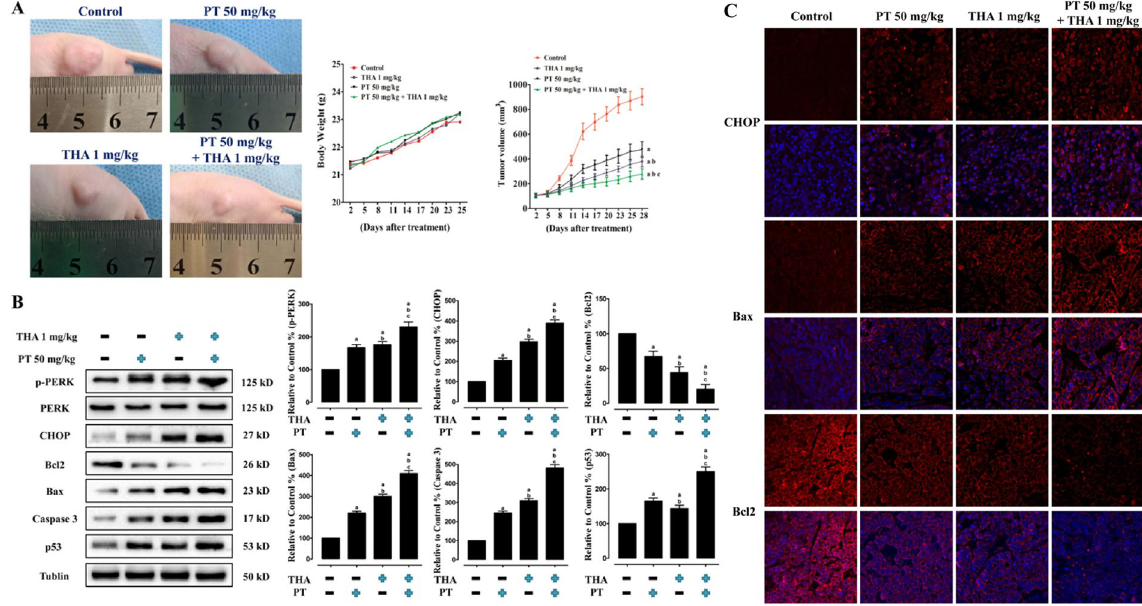
Figure 8. Effect of PT treatment combined with THA on tumor volume, body weight of nude mice, ERS pathways and apoptosis-associated proteins on PC9 tumor xenografts in vivo . ( A ) Photographs showing tumor xenograft morphologies in each group, changes in body weight of nude mice, and tumor growth curve drawn from the tumor volumes and treatment duration were provided. ( B ) Representative western blot results of the key proteins, including p-PERK, CHOP, Bcl2, Bax, Caspase 3, and p53 were shown. Membranes were re-probed for Tublin expression to show that similar amounts of protein were loaded in each lane. ( C ) Representative immunohistofluorescence staining images showed CHOP (red fluorescence) in the cell nucleus, Bax and Bcl2 (red fluorescence) in the cytoplasm, and DAPI (dark blue fluorescence) in the cell nucleus. The results were expressed as the mean ± SD; n = 6. a P < 0.05 vs . the control group, b P < 0.05 vs . the 50 mg/kg PT-treated group, c P < 0.05 vs . the 1 mg/kg THA-treated